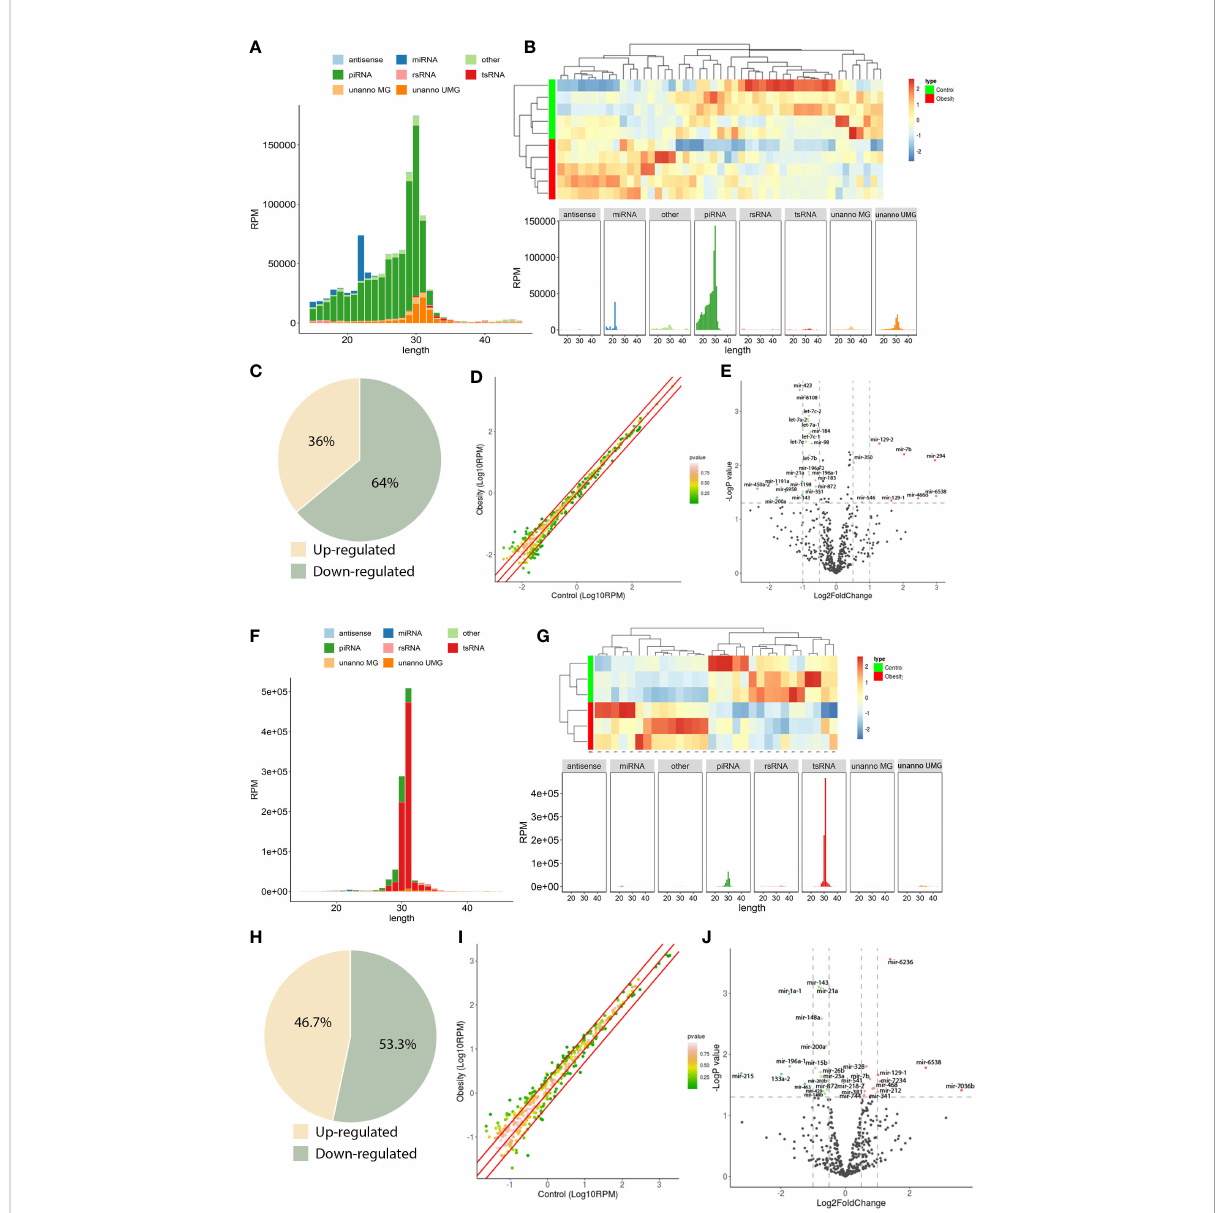
FIGURE 2 sncRNA dynamics in mouse round spermatids and epididymal spermatozoa. (A) , sncRNA length distribution in round spermatids. (B) , Heatmap of signi fi cantly differentially expressed miRNAs in round spermatids. Upregulated miRNAs are marked red, and downregulated miRNAs are marked blue. (C) , Scatterplot of miRNA expression variation between the obesity and control groups in round spermatids. The normalized expression values of each gene are shown on the x-axis and the y-axis. The miRNAs above the top red line or below the bottom red line had more than a twofold difference in expression between the two groups. (D) , The expression of a cohort of miRNAs in round spermatids from the obesity group differed from that in the control group. Of the 47 differentially expressed miRNAs, 17 were upregulated, and 30 were downregulated. (E) , Volcano plots of miRNA expression variation between the two groups in round spermatids. Red and green dots indicate signi fi cantly upregulated and downregulated miRNAs in the obesity group, respectively (P < 0.01). Gray dots represent nondifferentially expressed genes between the two groups. (F) , Length distribution of sncRNAs in epididymal spermatozoa. (G) , Heatmap of signi fi cantly differentially expressed miRNAs in epididymal spermatozoa. Upregulated miRNAs are marked red, and downregulated miRNAs are marked blue. (H) , Scatterplot of miRNA expression variation in epididymal spermatozoa between the obesity and control groups. The normalized expression values of each gene are shown on the x-axis and the y-axis. The miRNAs above the top red line or below the bottom red line had more than a twofold difference in expression between the two groups. (I) , The expression of a cohort of miRNAs in epididymal spermatozoa from the obesity group differed from that in the control group. Of the 30 differentially expressed miRNAs, 14 were upregulated, and 16 were downregulated. (J) , Volcano plots of miRNA expression variation between the two groups in epididymal spermatozoa. Red and green dots indicate signi fi cantly upregulated and downregulated miRNAs in the obesity group, respectively (P < 0.01). Gray dots represent nondifferentially expressed genes between the two